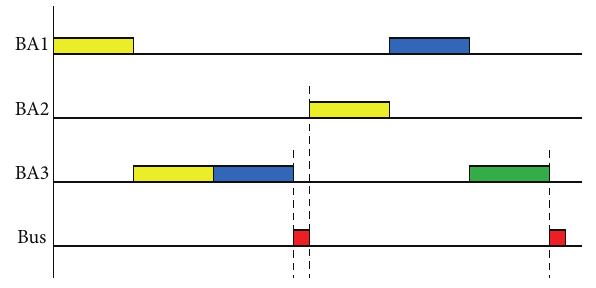
Figure 10: Timing diagram of the asynchronous model.